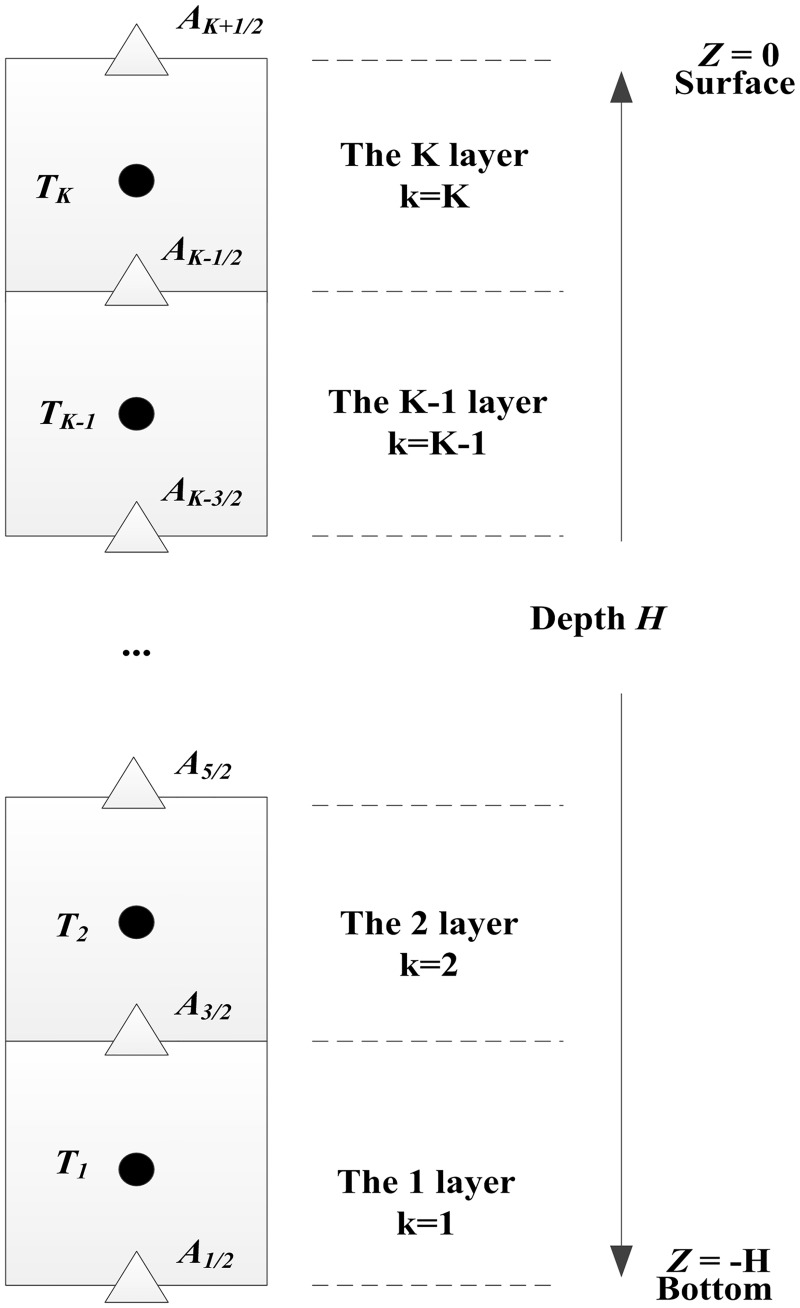
Layout of variables.